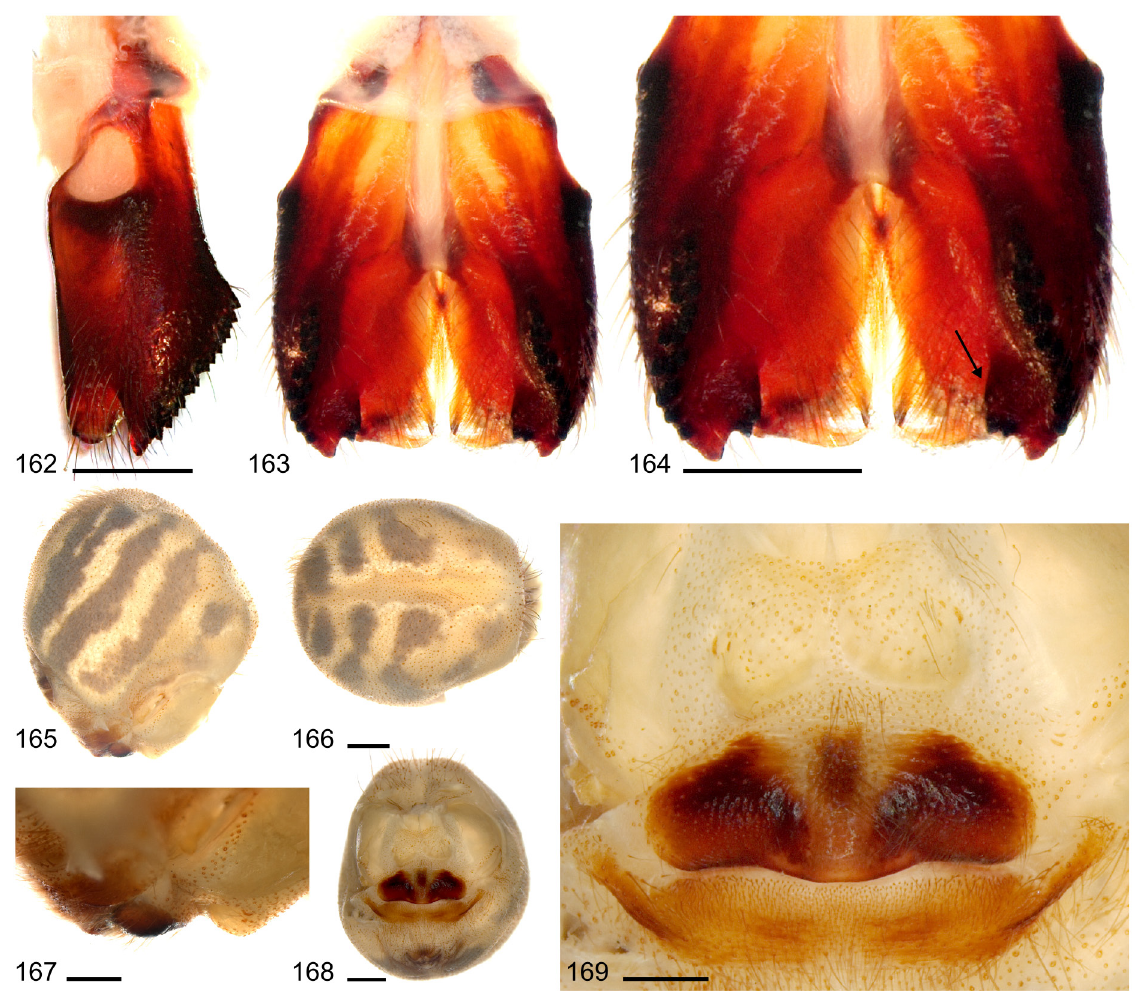
Figs 162–169. Artema magna Roewer, 1960. 162–164 . Male chelicerae (ZMMU, Pakistan, Baluchistan Province, Quetta), lateral and frontal views (arrow: distinctive median projection). 165–166, 168 . Female abdomen (NHMG A 196, Afghanistan, Konar Valley): lateral, dorsal, and ventral views. 167, 169 . Epigynum and anterior epigynal projections (AEP): lateral and ventral views. Scale lines: 162–164, 167, 169 = 0.5 mm; 165–166, 168 =